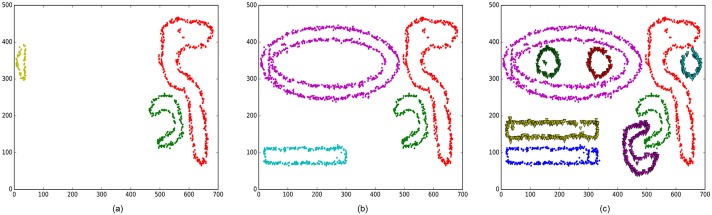
The evolution process of the BPIC results, in which the bucket size is 3500.(a) The initial boundary clustering results on 3000 data points from the Chameleon DS3 dataset. (b) The first updated clustering results after 3500 data points are added. (c) The second updated clustering results after 7000 data points are added.